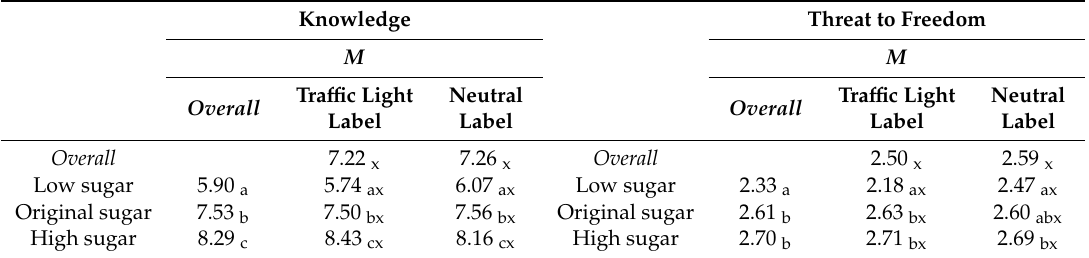
Table 4. Estimated marginal means of knowledge and threat to freedom ratings for products with low, original, and high sugar level in the tra ffi c light label and neutral label